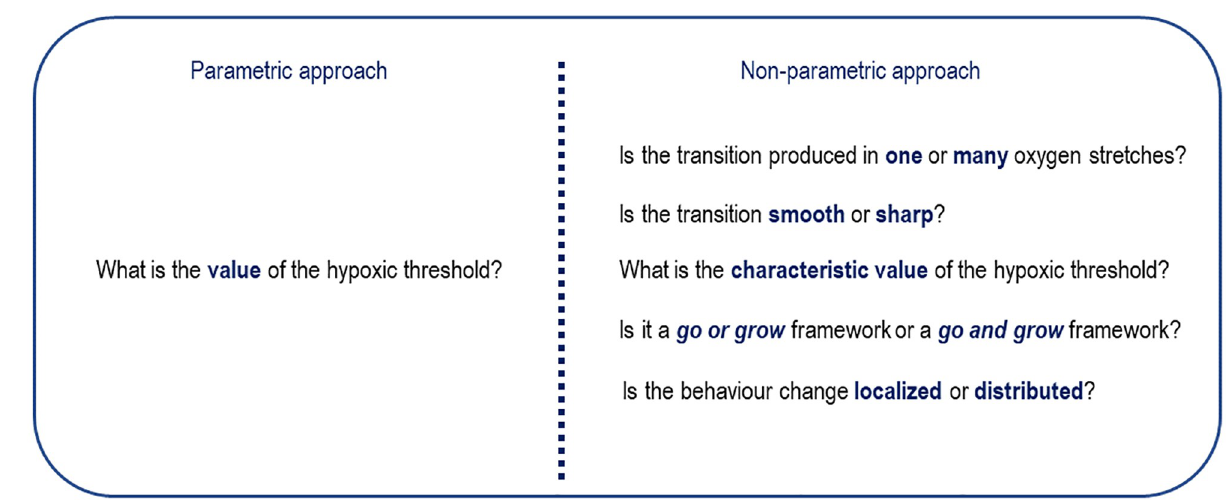
Fig 8. Parametric vs non-parametric approaches. The degree of information about the cell metabolism is richer in the non-parametric approach.